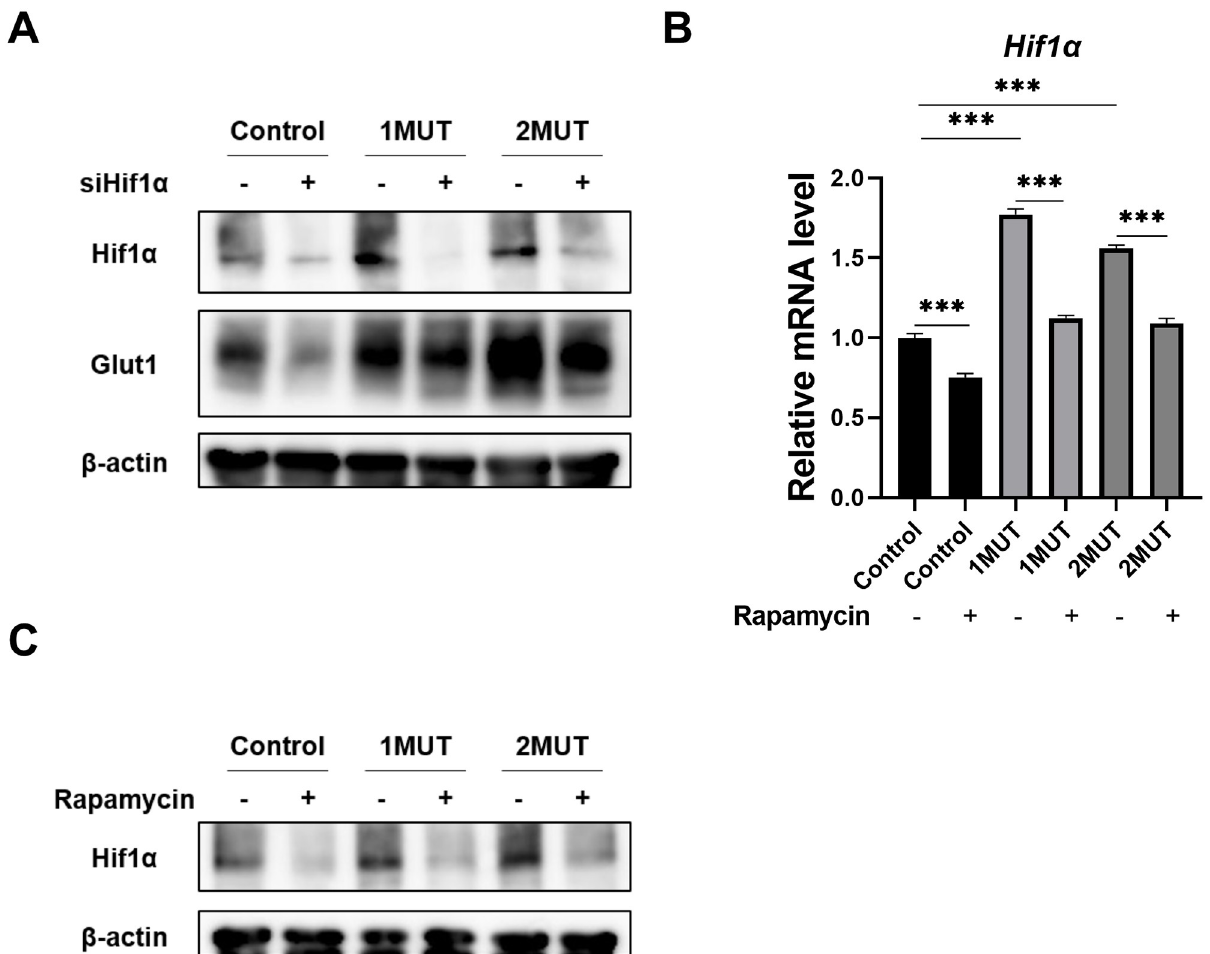
Fig 6. Involvement of Hif1 α in the induction of Glut1 in MEF cells. (A) MEF-1MUT, MEF-2MUT, and the control cells were treated with Hif1 α or control siRNA for 48 h. Expression of β -actin served as an internal control. (B) MEF-1MUT, MEF-2MUT, and the control cells were treated with 20 nM of rapamycin for 24 h. Expression was determined by real time-PCR. Expression of Gapdh was used as an internal control. The data represent mean ± SD of three independent experiments. ��� p < 0.001. (C) The lysates of MEF cells indicated in (B) were subjected to Western blotting.